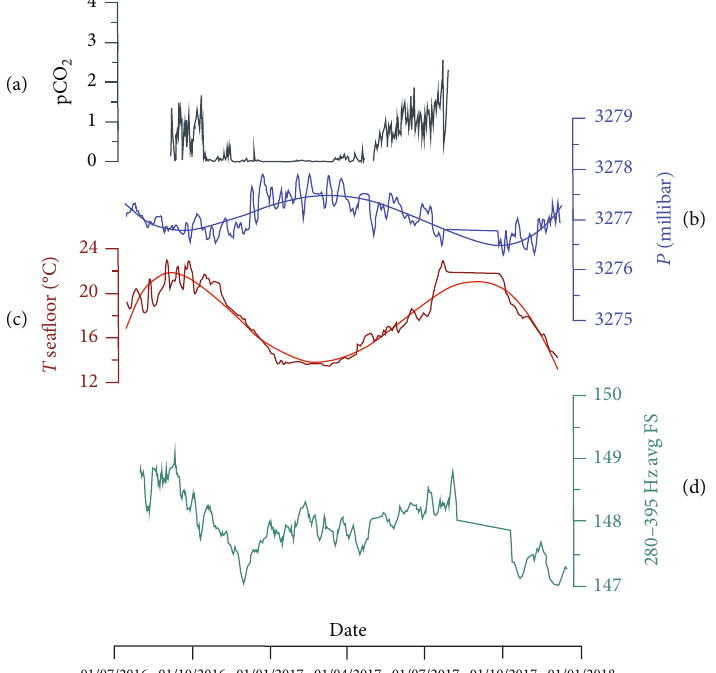
Figure 5: Example of long data series acquired by the multidisciplinary observatory: (a) percentage of dissolved CO pressure together with the 3rd order polynomial line highlighting its seasonality; (c) sea fl oor temperature (dark-red line) together with the 3rd order polynomial (light-red line) highlighting its seasonality; and (d) passive acoustic record RMS modulation over the range 280-395 Hz (associated to bubble stream cluster acoustic source), representing how sound pressure intensity changes over time. Acoustic series was further fi ltered by seasonality induced by environmental